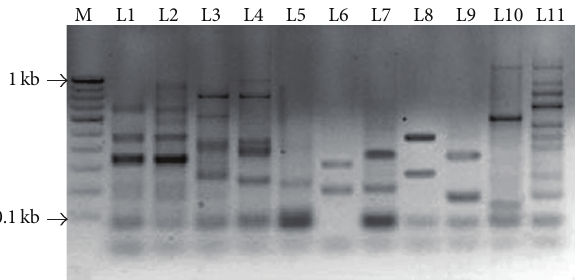
Figure 3: PCR amplification of ESM-28 primer in eleven plants belonging to five different families. Lane 1 Datura metel , 2 Datura innoxia , 3 Withania coagulans , 4 Withania somnifera , 5 Capsicum annuum , 6 Stevia rebaudiana , 7 Eclipta alba , 8 Citrullus colocynthis , 9 Ocimum sanctum , 10 Catharanthus roseus , and 11 Moringa oleifera .